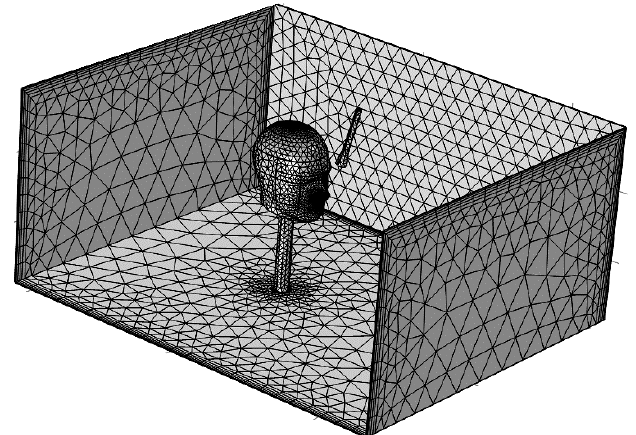
Figure 3. Generation of tunnel grid.